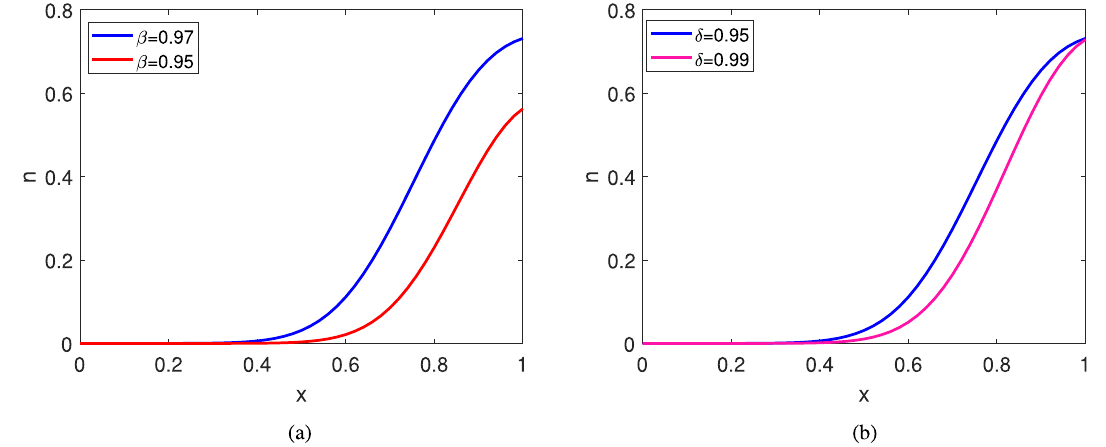
Figure 5. Comparison of cell’s wavefront inside filter at time t = 5 : ( a ) for different parameter values of β with fix parameter δ = 0.95 , ( b ) for different parameter values of δ with fix parameter β = 0.97 . Other parameter values are given in Table22.